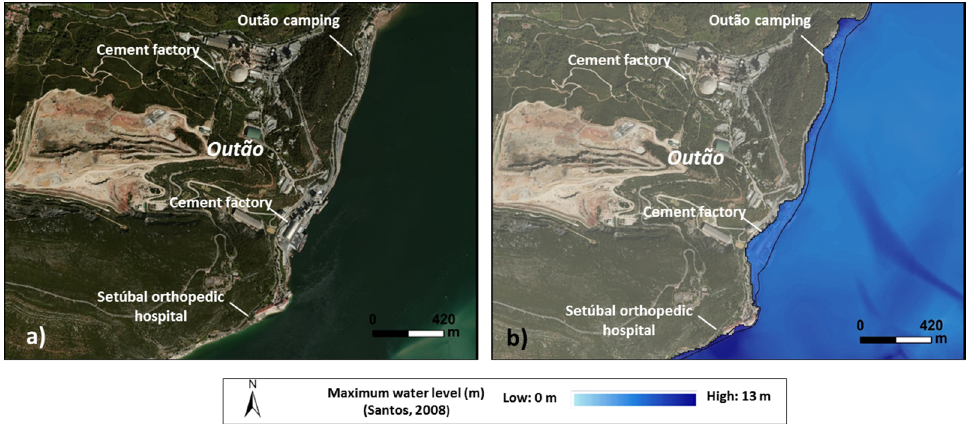
Figure 5. Outão study area: ( a ) Satellite image from study area; ( b ) Tsunami inundation from numerical model results for Outão